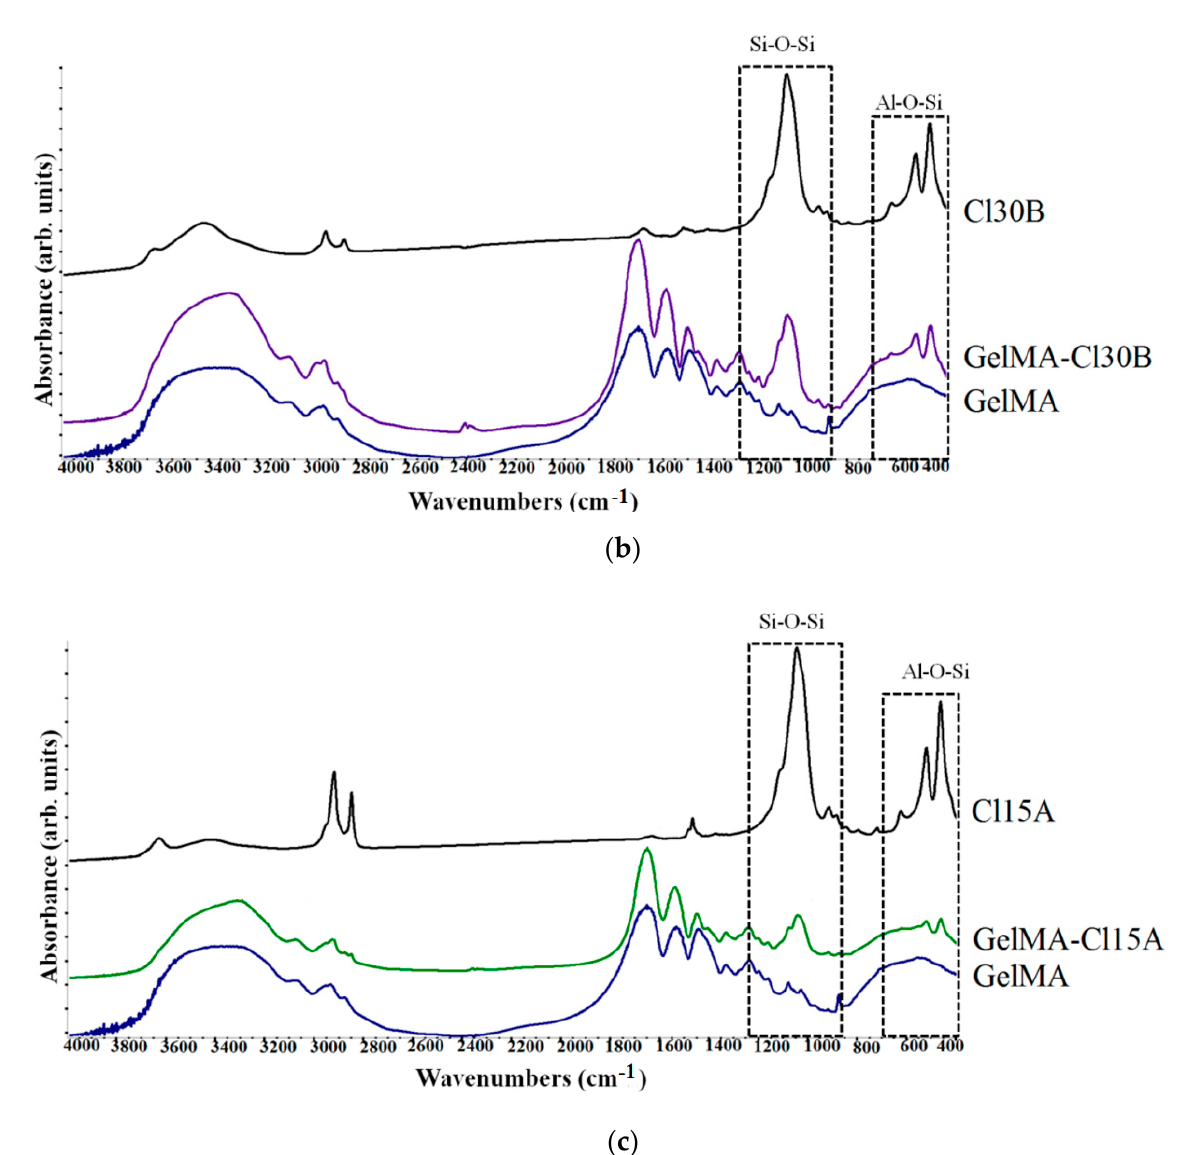
Figure 2. ( a ) FTIR spectra of commercial Cloisite Na, synthesized GelMA–Cloisite Na and GelMA matrix; ( b ) FTIR spectra of commercial Cloisite 30B, synthesized GelMA–Cloisite 30B and GelMA matrix; ( c ) FTIR spectra of commercial Cloisite 15A, synthesized GelMA–Cloisite 15A and GelMA